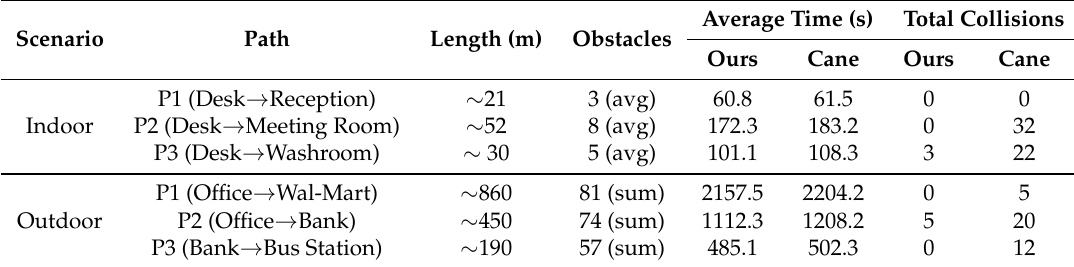
Table 3. Results of navigation with Cane and our assistance.